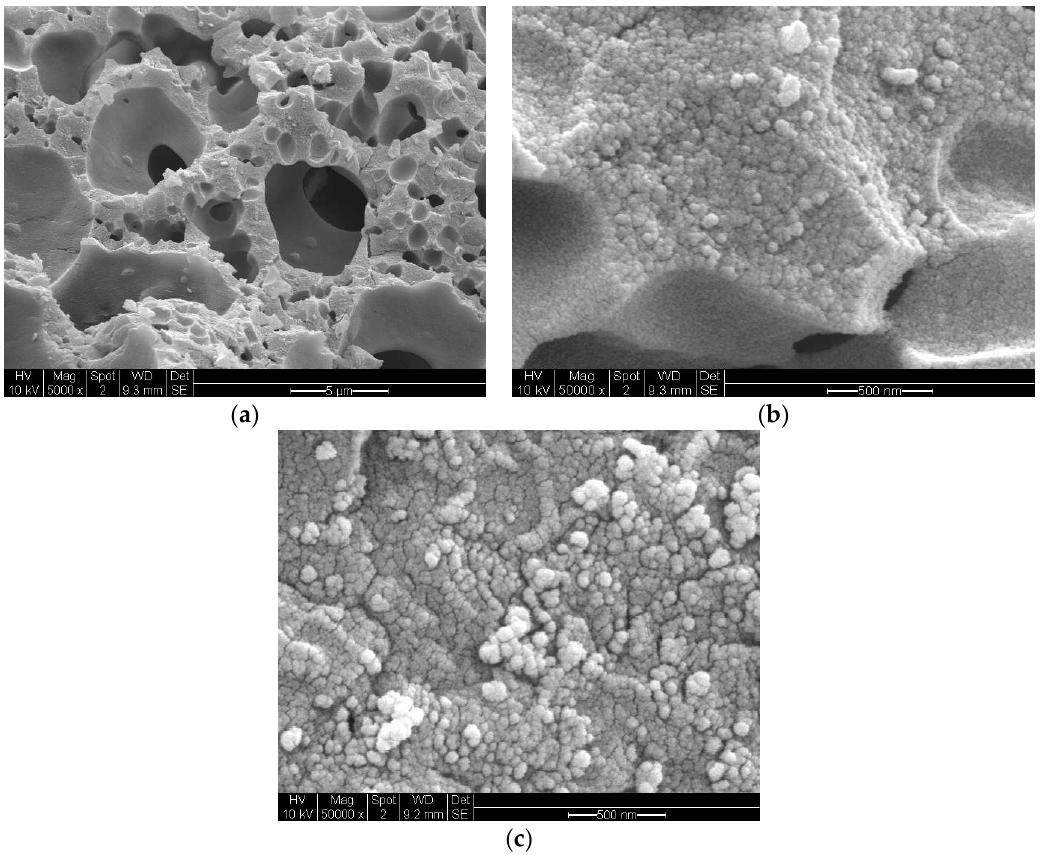
Figure 19. Scanning electron microscopy of sample Ni/Si = 1/4 Mw ‐ AB obtained after the microwave irradiation at 1 kW of supported catalyst precursor fluid to obtain NiO followed by heat treatment at 600 °C (Method ‐ C, Section 3.8). ( a ) Porous structure (Scale bar = 5 μ m); ( b ) Wall structure (Scale bar = 500 nm); ( c ) Surface structure (Scale bar = 500 nm).